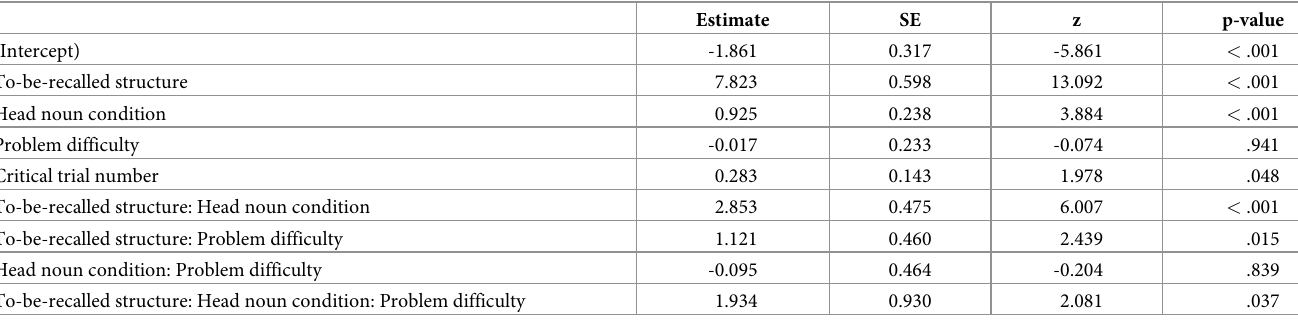
Table 6. Fixed effect estimates (in log odds units), Experiment